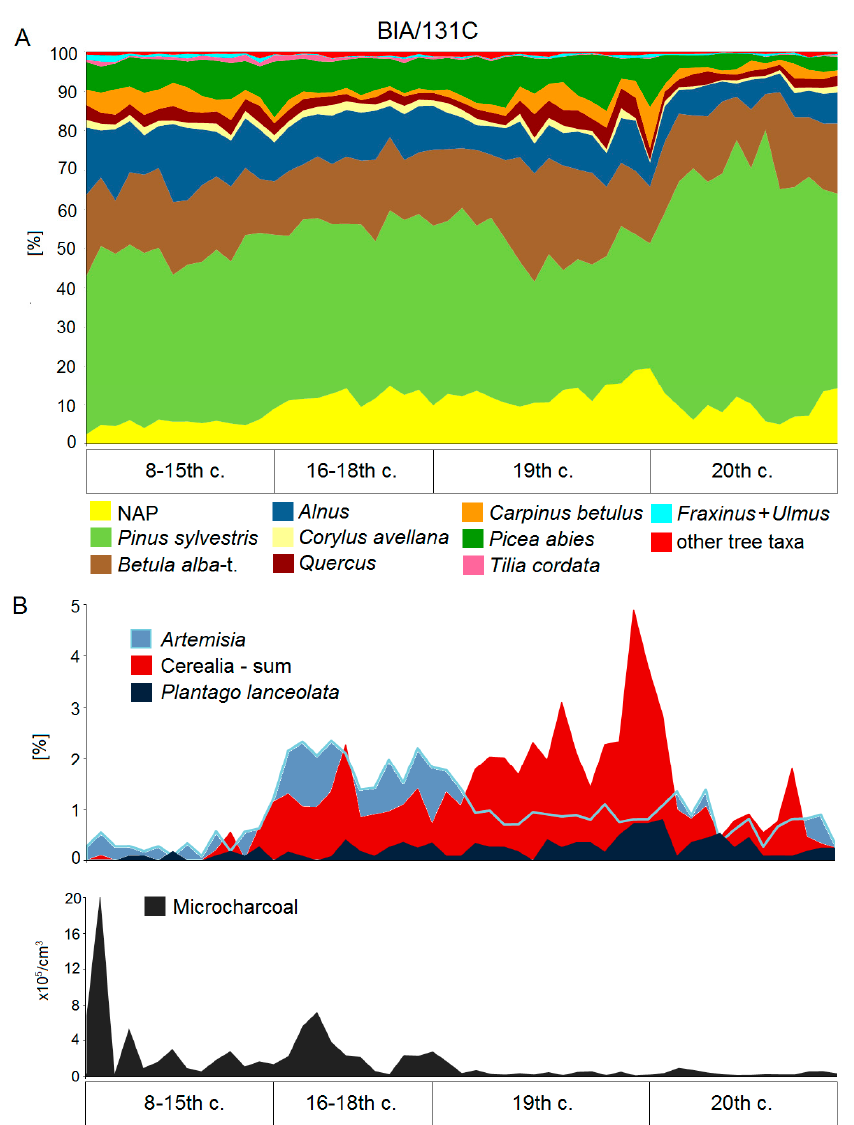
Figure 3. Selected palynological data from the BIA / 131C site (see Figure 1B) illustrating BF history in the mediaeval and modern times: ( A ) Changes in the pollen proportions of the main tree taxa and non-arboreal pollen (NAP); ( B ) Changes in the pollen proportions of Artemisia , Cerealia (sum) and Plantago lanceolata , and concentration of microcharcoal particles in the sediments. The age scale is based on an OxCal age / depth model considering 8 14 C dates and 210 Pb dating. Source of the data: [120]. In the late mediaeval period, BF was the hereditary property of Lithuanian grand dukes [144], and had been a royal forest since the Polish-Lithuanian union of 1385. From that time until the end of the 18th century, BF was protected with the aim of preserving so called animalia superiora: European bison, brown bear Ursus arctos L., red deer Cervus elaphus L., and moose Alces alces L. for the purposes of royal hunts. However, between 1409 and 1784 fewer than 20 royal hunts have been confirmed by written sources [145] which implies that they had a rather limited impact on the forest’s